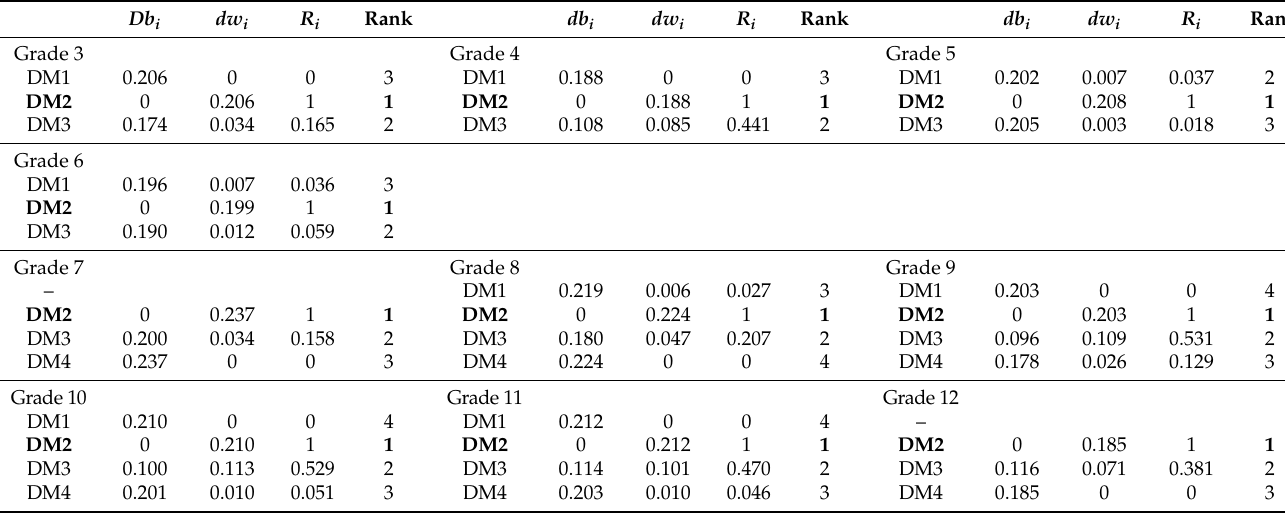
Table 6. Ranking the alternatives prone to